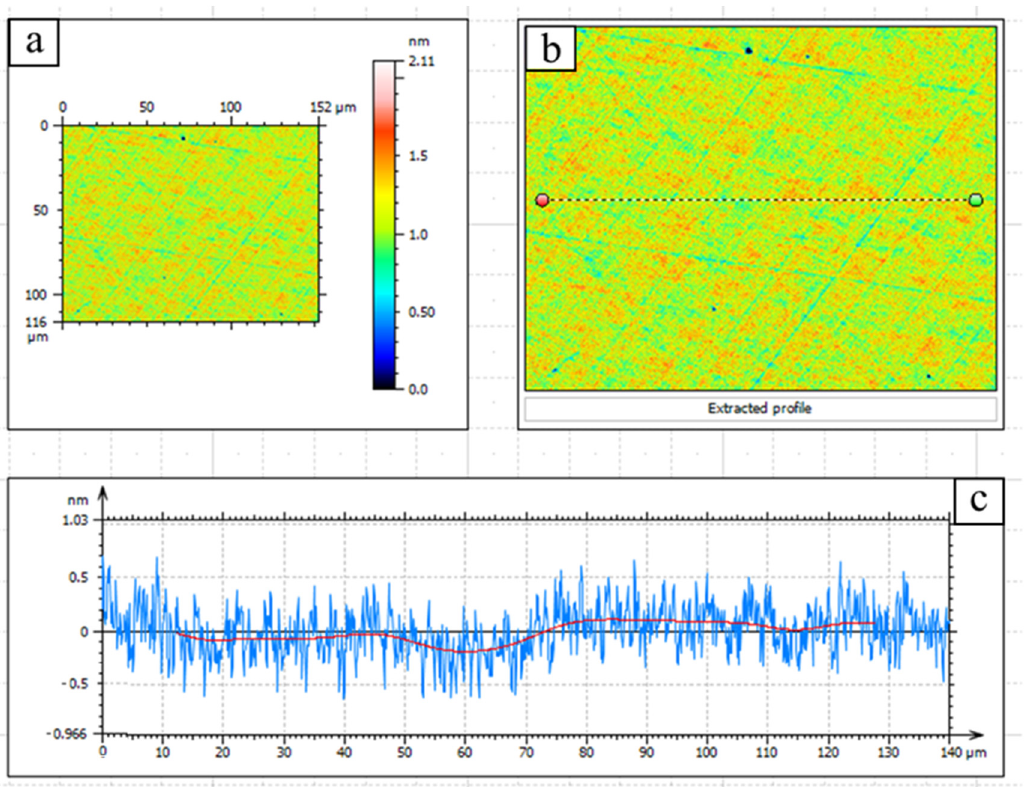
Figure 3. Surface topography and roughness profile of sample No. 2 after MRP. ( a ) Surface topography of sample, ( b ) Surface topography of sample with a dashed line, ( с ) roughness profile of the sample along the dashed line.